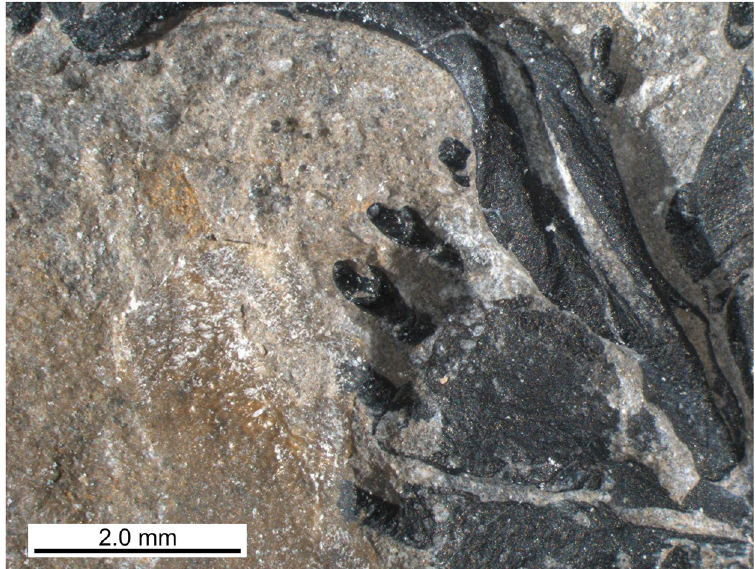
Figure 5. Detail of the premaxillary region of the skull of Eusaurosphargis dalsassoi (PIMUZ A/III